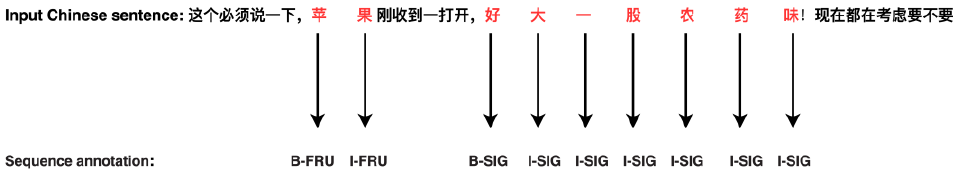
Figure 5. Sequence annotation instance. According to the BIO labeling scheme, B indicates the beginning of an entity, I indicates an intermediate entity, and O indicates a non‑entity. The Chinese word “ 苹果 ” indicates the apple, labeled as “B‑FRU, I‑FRU,” and the Chinese characters “ 好大一股农药味 ” describing apples with a strong pesticide smell is a food safety risk description and is labeled as “B‑SIG, I‑SIG, I‑SIG, I‑SIG, I‑SIG, I‑SIG, I‑SIG”. The rest of the Chinese characters are marked as